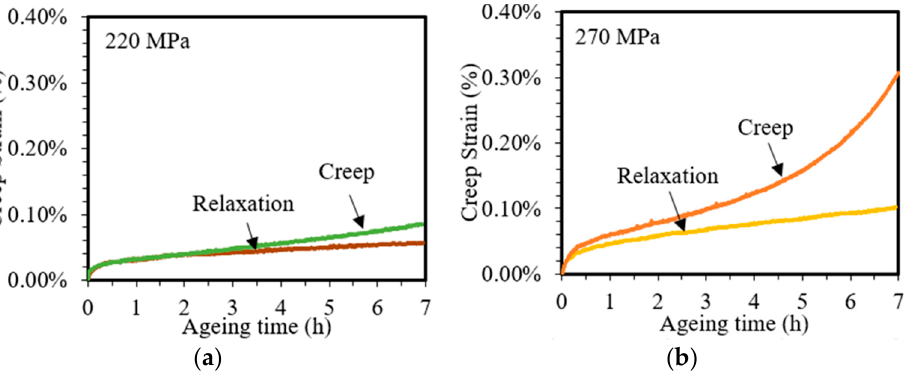
Figure 4. Comparison between creep and stress relaxation curves of 7050 aluminum alloy with ( a ) 220 MPa and ( b ) 270